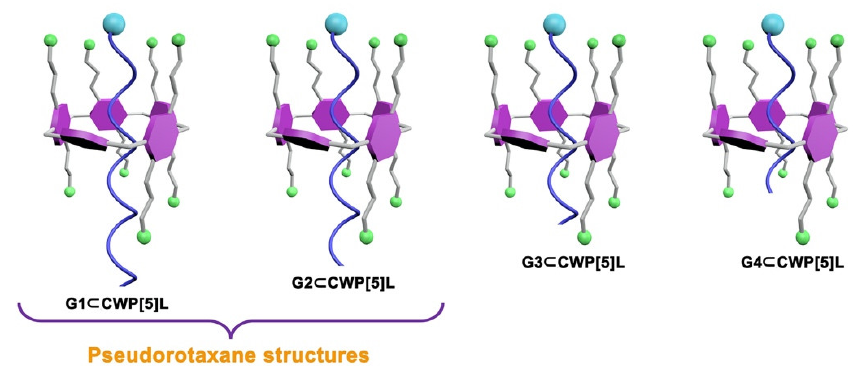
Figure 2. Cartoon representation of the 1:1 inclusion complexation between CWP[5]L and guests G1 - G4 (from left to right), and the [2]pseudorotaxane structures of the complexes of G1 ⊂ CWP[5]L and G2 ⊂ CWP[5]L .